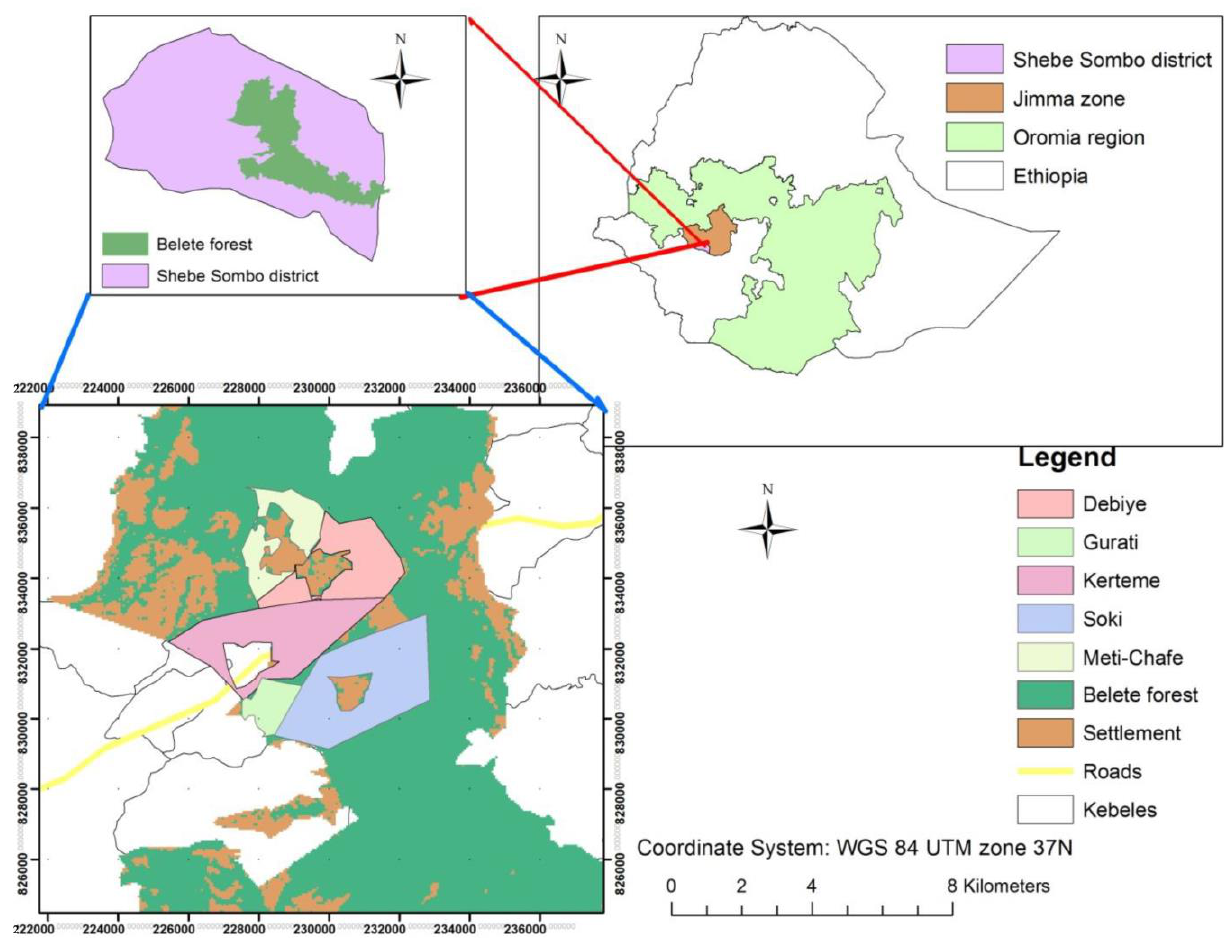
Figure 1. Map of Ethiopia illustrating the Oromia region, Jimma zone, Shebe Sombo district, Belete forest and study sites.